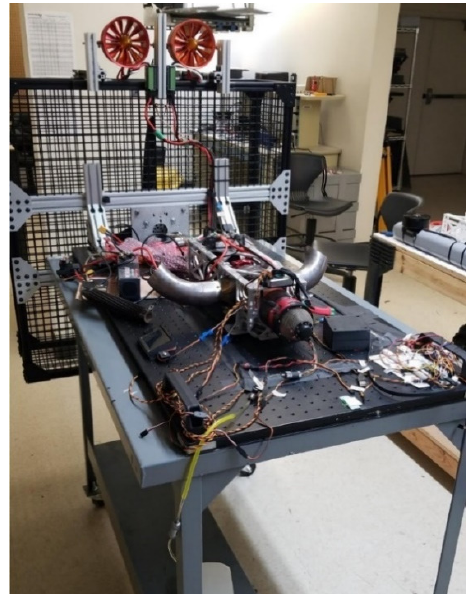
Figure 4. A photo of the bench test stand with the K-60TP-based system installed, showing the avail- able electric loads of the 28 in. propeller motor and two additional five kW EDFs. available electric loads of the 28 in. propeller motor and two additional five kW